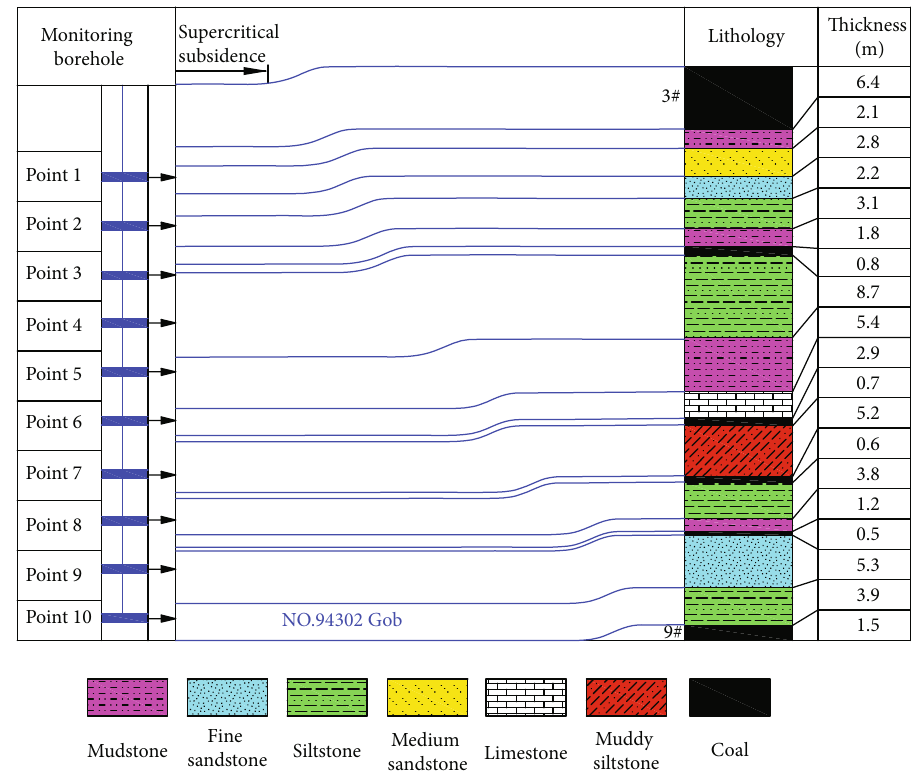
Figure 8: The geological condition and monitoring point arrangement.